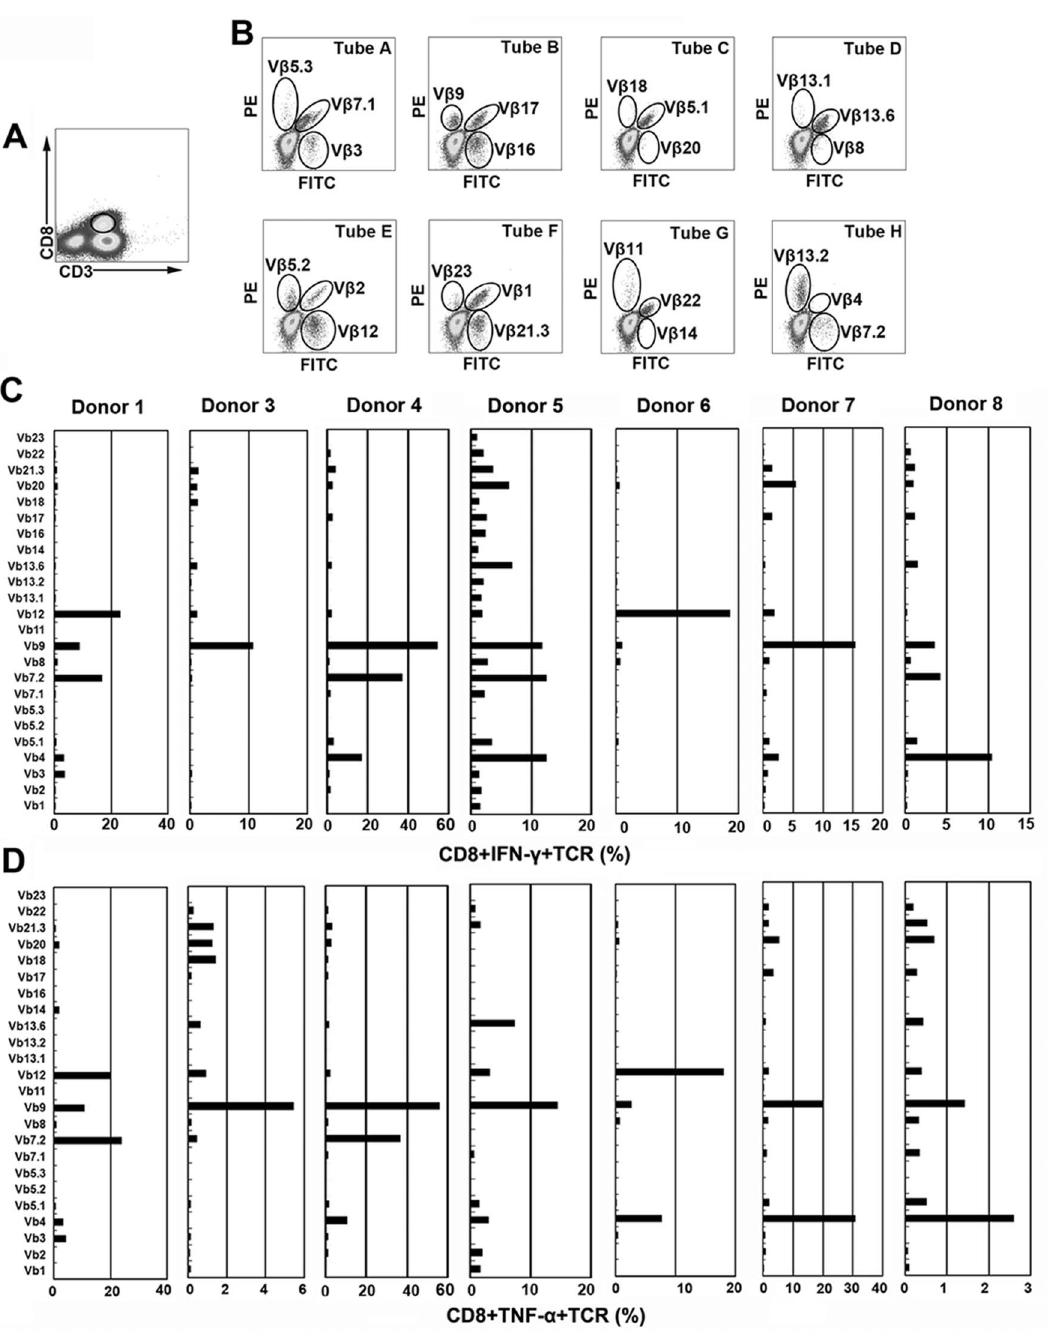
Figure 6. TCR V b repertoires of CFP10 9aa peptide-specific IFN- c or TNF- a -producing CD8 + T cells in PFCs from TBP. (A) Representative gating strategy of CD8 + T cells as assessed by flow cytometry in PFCs was shown. CD8 + T cells were gated according to the expression of CD3 and CD8. (B) The expression of 24 TCR V b chains by CD8 + T cells was assessed. Analysis of 24 TCR V b chains was performed by staining in eight tubes, from A to H. In each tube, one TCR V b antibody was conjugated to FITC, another to PE, and a third to both FITC and PE. (C) PFCs were stimulated with each 9aa peptide (Donor 1 and Donor 3: TAGSLQGQW; Donor 4 and Donor 5: NIRQAGVQY; Donor 6 and Donor 7: EMKTDAATL; Donor 8: QEAGNFERI) for 8 h. Percentages of IFN- c production by CD8 + T cells expressing each TCR V b chain was indicated for each donor. (D) Percentages of TNF- a production by CD8 + T cells expressing each TCR V b chain was indicated for each donor.